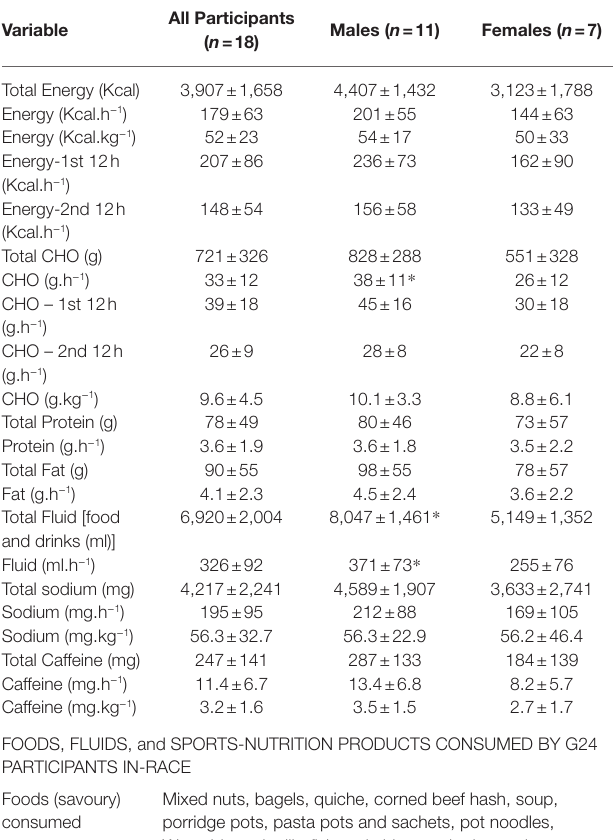
TABLE 2 | Nutritional composition (mean ± SD) of all foods and fluids consumed by participants over the 24-h race duration (in-race diet), and actual foods, fluids, and sports-nutrition products consumed by n = 18 participants during the Glenmore 24 trail